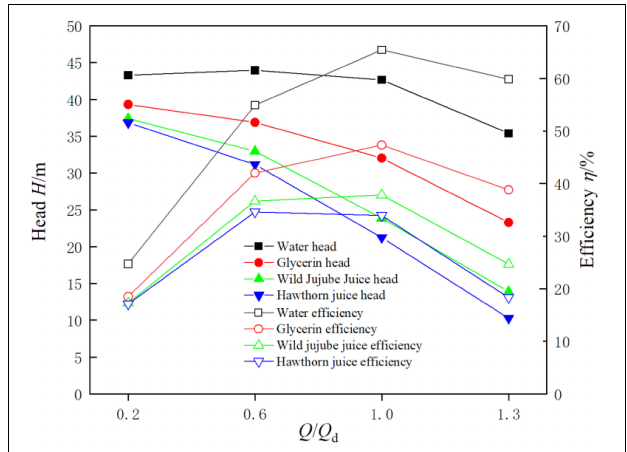
FIGURE 7 | External characteristics of the centrifugal pump with different viscosity.